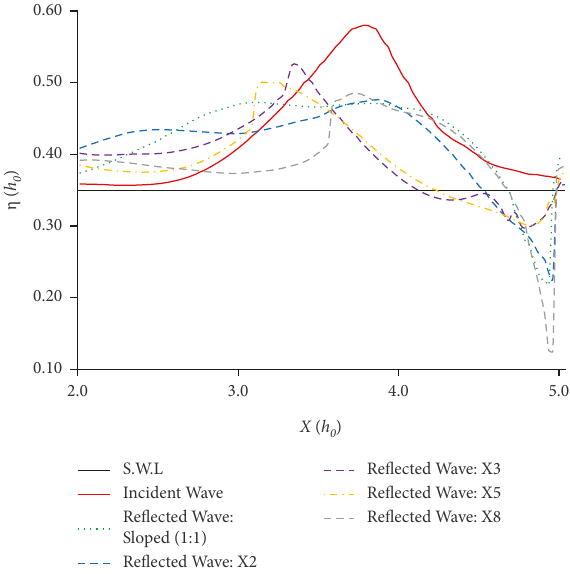
Figure 10: Model results of reflected wave height for parabolic and sloped walls.